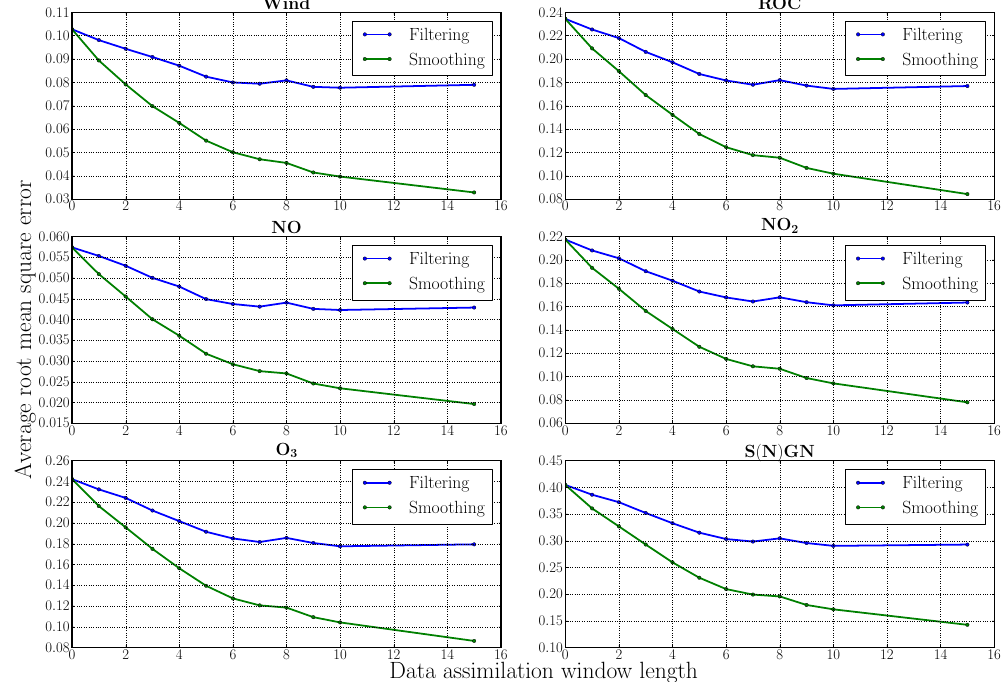
Figure 9. Average filtering and smoothing analysis RMSEs of the L95-GRS variables, as a function of the DAW length (in units of (cid:49)t = 6h). The case L = 0 corresponds to the ensemble transform EnKF. The RMSEs are normalised by the standard deviations of the observation error.